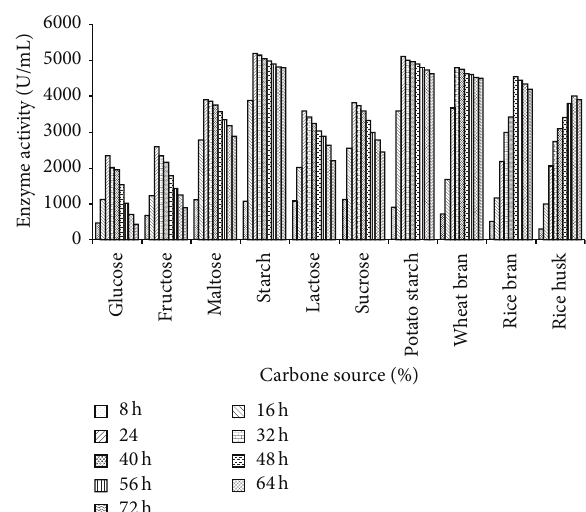
Figure 6: Effect of different carbon sources and incubation periods on amylase production. Test flasks contained different carbon sources in the medium at a level of 2% (w/v). The flasks were ino- culatedwithcultureandincubatedat55 ∘ Cfor4–48hatpH7.0.Error bars presented are mean values of ± standard deviation of triplicates of three independent experiments.